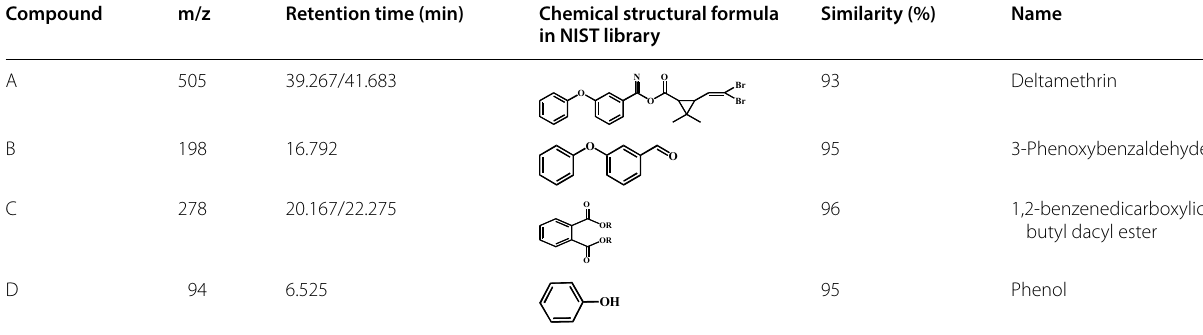
Table 1 Chromatographic properties of metabolites of deltamethrin by strain LH-1-1, co-culture strains LH-1-1 and BPBA052